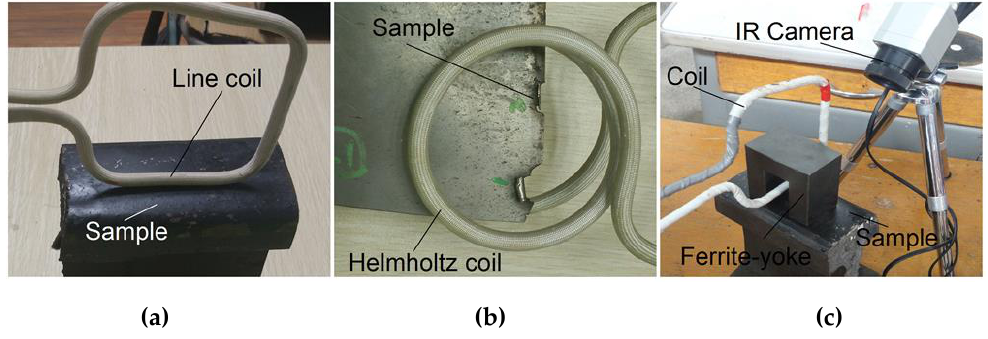
Figure 8. ECPT with different configurations. ( a ) Line-coil ECPT. ( b ) Helmholtz-coil ECPT and ( c ) Ferrite-yoke-based structure for ECPT.